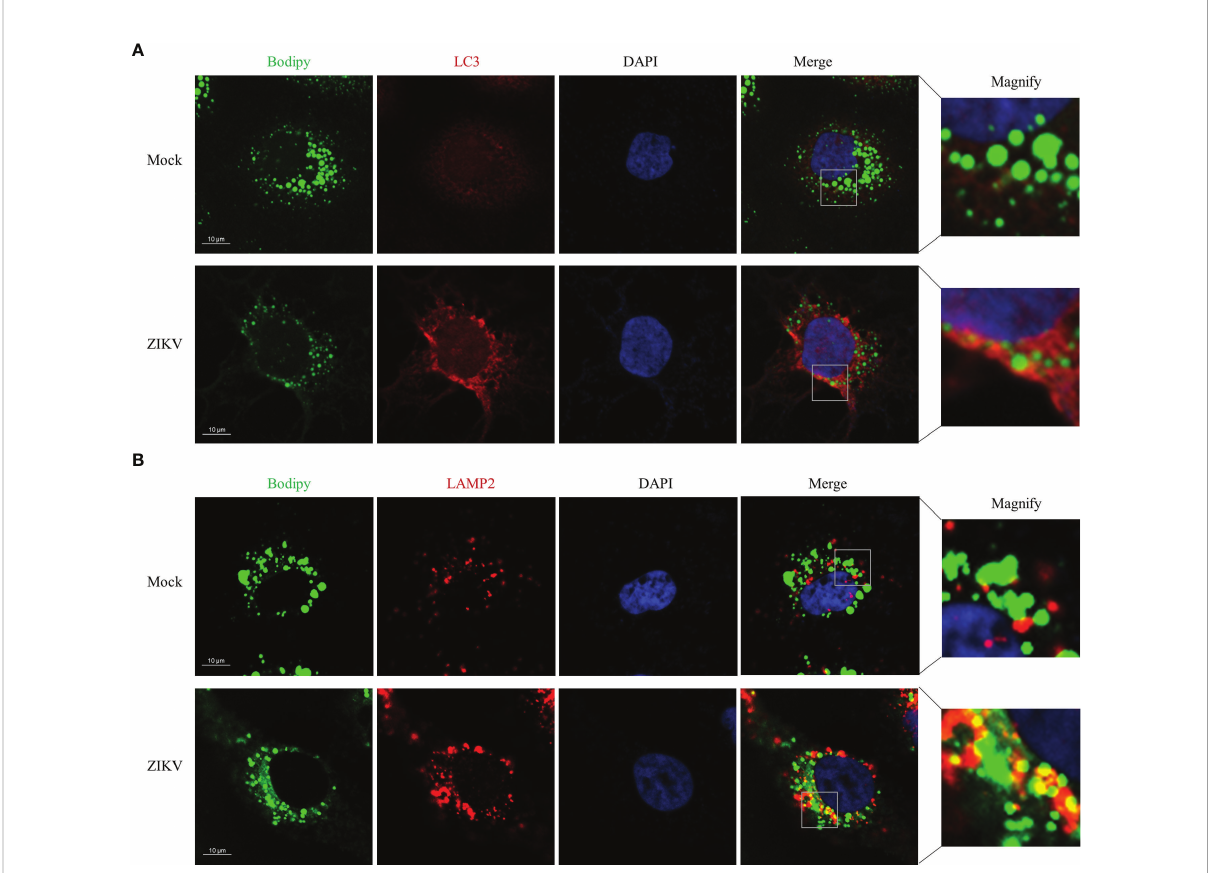
FIGURE 3 ZIKV infection Promotes LD-lysosome fusion in Huh7 cells. Huh7 cells were infected with ZIKV at an MOI of 1 or mock-treated for 24 h. The cells were fi xed, stained with BODIPY dye or immunostained for LC3B (A) or LAMP2 (B) . Co-localization of LD with LC3-II or LAMP2 was assessed via confocal microscopy. Representative images are presented. Bars, 10